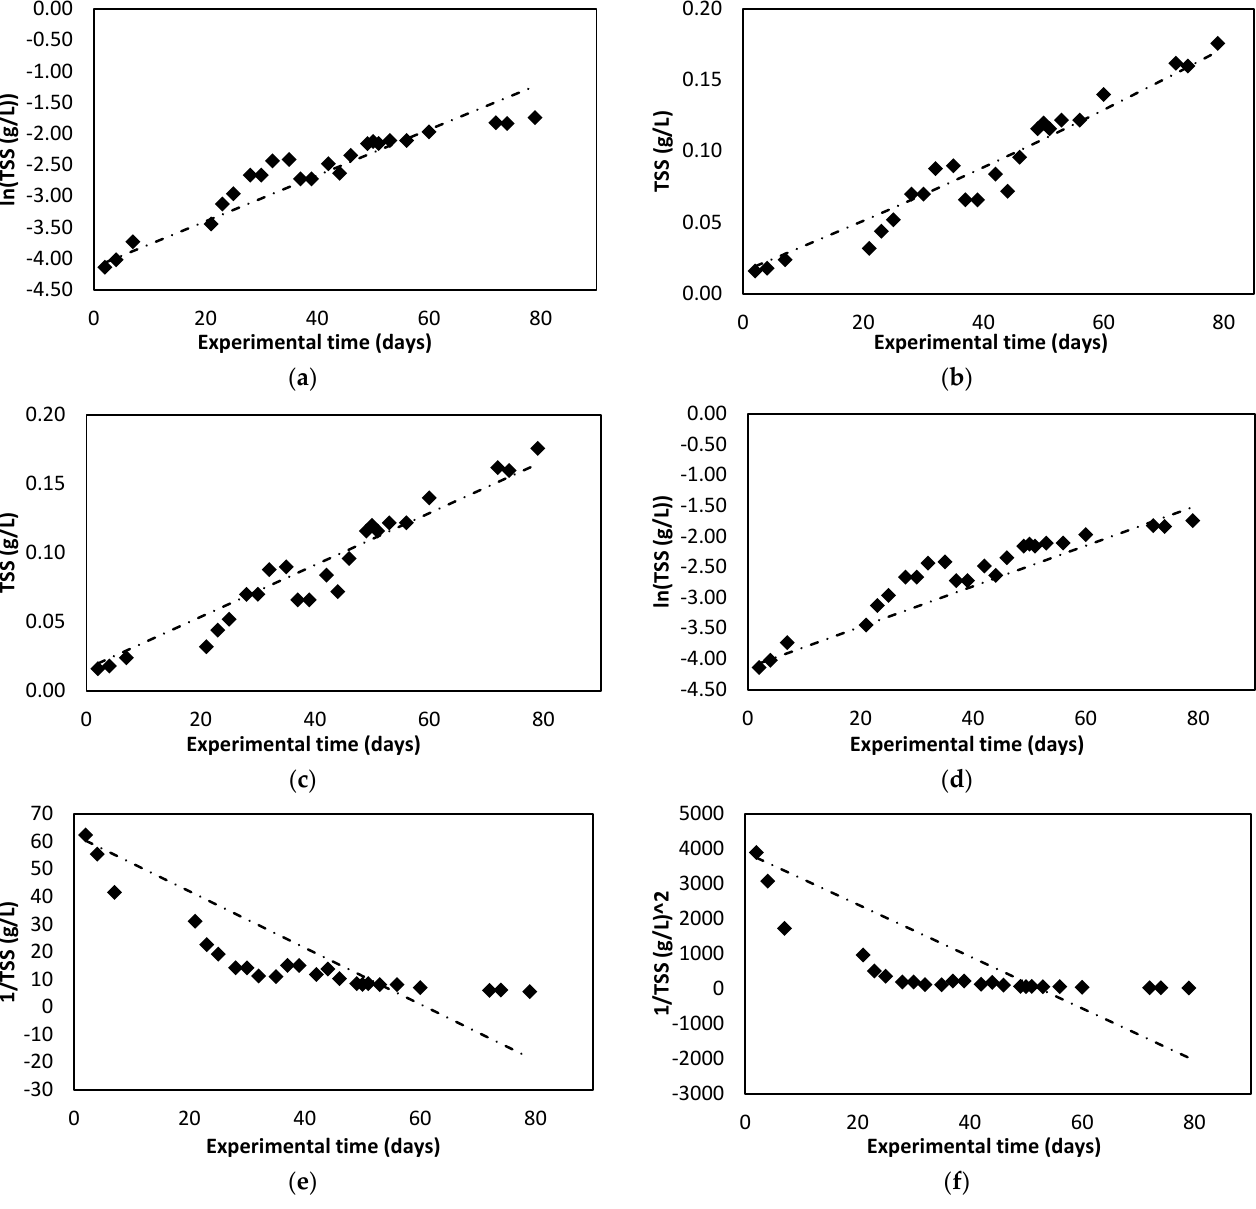
Figure 5. Fitting data for TSS to each kinetic model assessed. (a) Pseudo-first order. (b) Pseudo-second order. (c) Zero order. (d) First-order. (e) Second-order. (f) Third order.